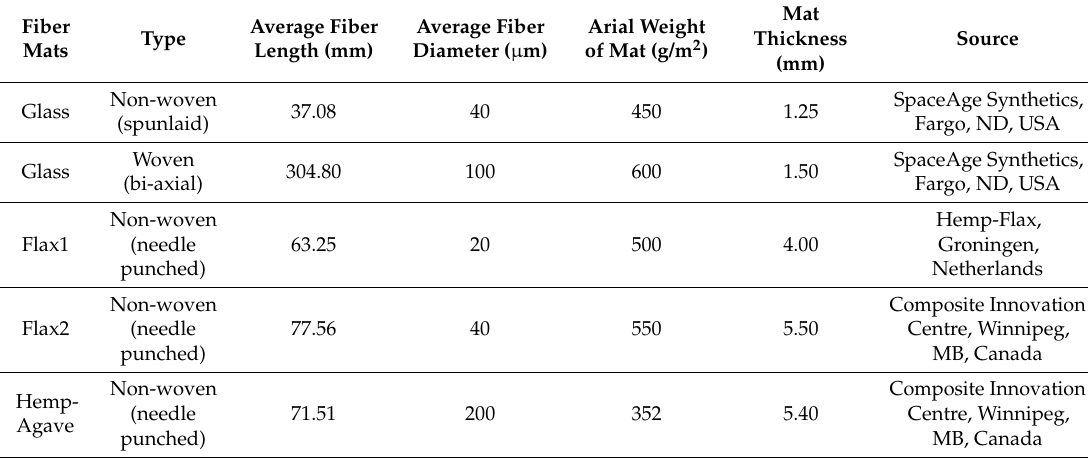
Table 1. Characteristics of the fiber mats used in the study. Fiber length and thickness are measured for 15 fibers from each